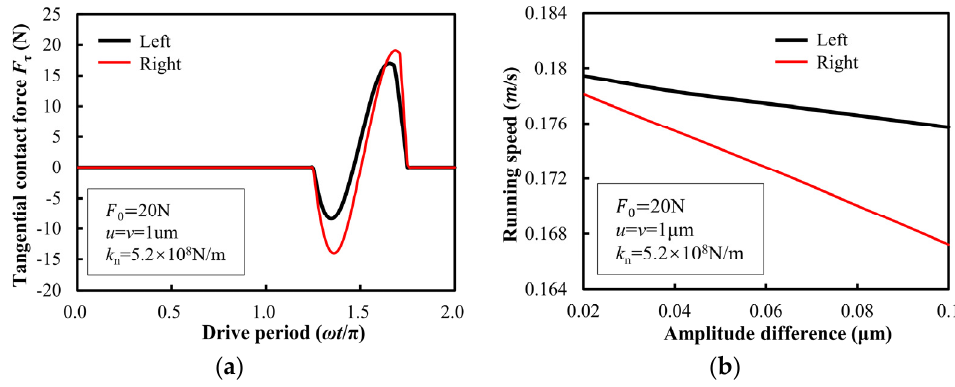
Figure 11. Asymmetry illustration of tangential contact force ( a ) and output speed ( b ) between stator and slider for the forward (e.g., right) and inverse (e.g., left) operations of the ultrasonic motor.